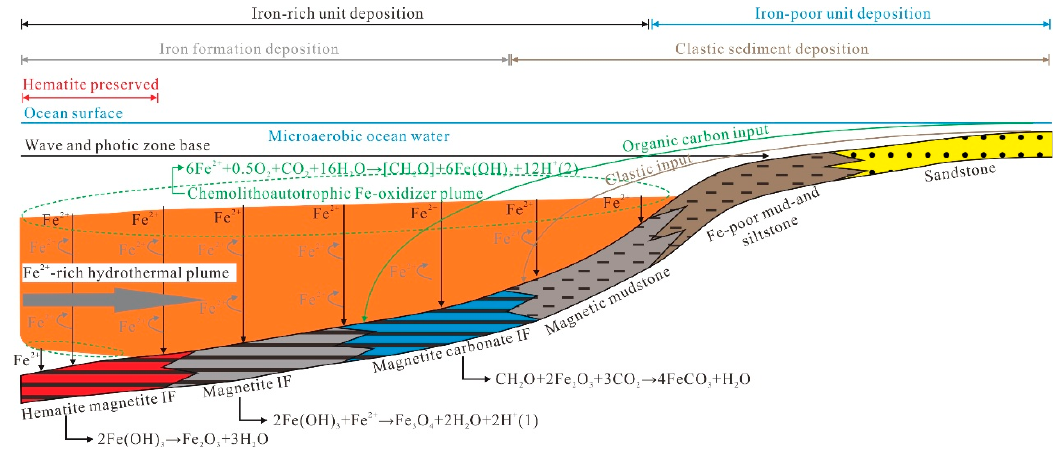
Figure 3. Depositional model of early Precambrian BIFs (modified after [92]). Most early Precambrian BIFs have undergone varying degrees of